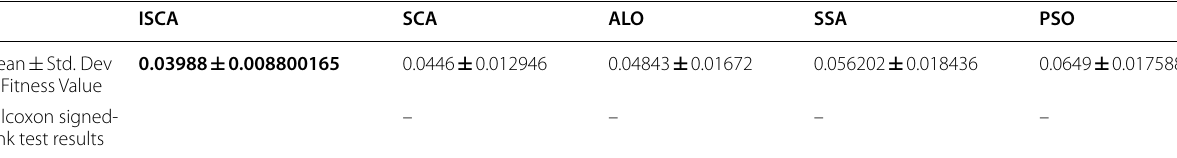
Table 11 Comparison of fitness values and WRST results of the four-area system with SLD of 2% in area-1 using Different Optimization Techniques (Values in bold shows best value) ISCA